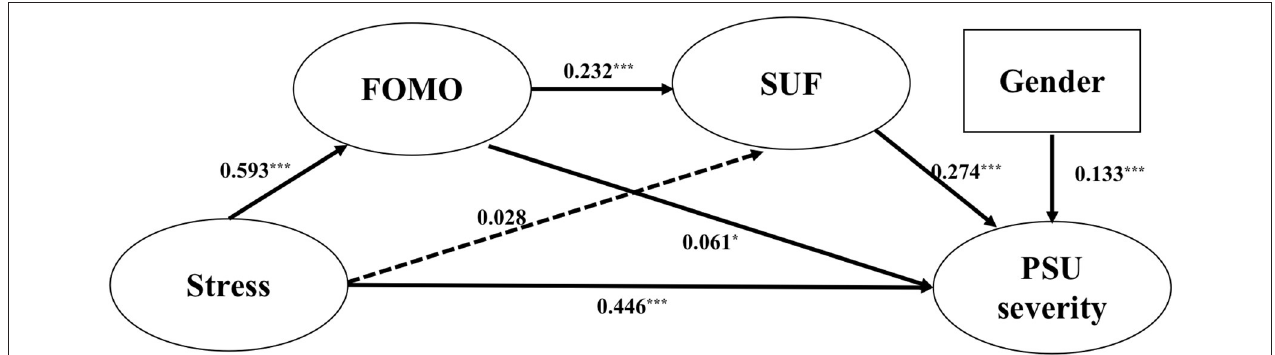
FIGURE 2 | Results of the structural equation model. * p < 0.05; *** p < 0.001.